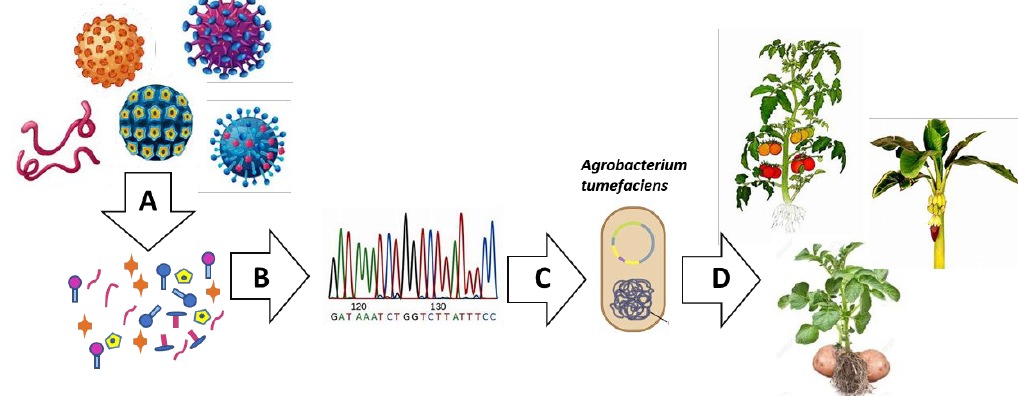
Figure 3. General workflow of antigen production: ( A ) Peptides tested to boost immunity response can be isolated from human and animal pathogens. In ( B ), the corresponding encoding sequences of the antigen can be amplified from the pathogen genome and cloned in an appropriate binary vector; ( C ) The binary vector carrying the antigen encoding sequence is transformed into A. tumefaciens ; ( D ) The recombinant A. tumefaciens is then used to infect plants and then introduce the recombinant sequence encoding the antigen into plant cells. Finally, obtained transgenic plants become platforms for the antigen production. The use of transgenic crops (such as, tomato, banana or potato) may allow us to exploit the edible part as direct oral antigen delivery for vaccination.